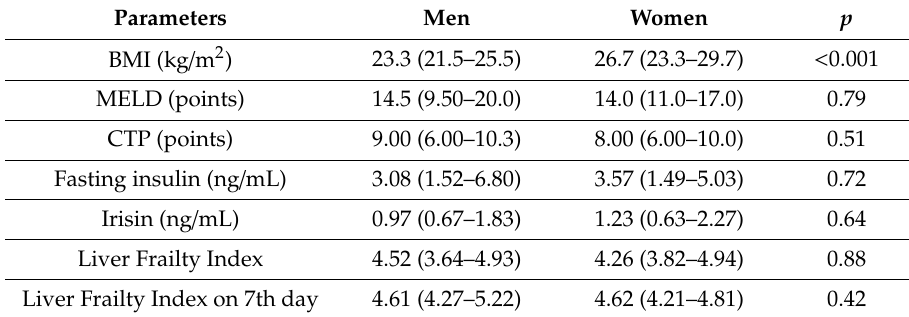
Table 2. Comparison of analyzed parameters between males and females with